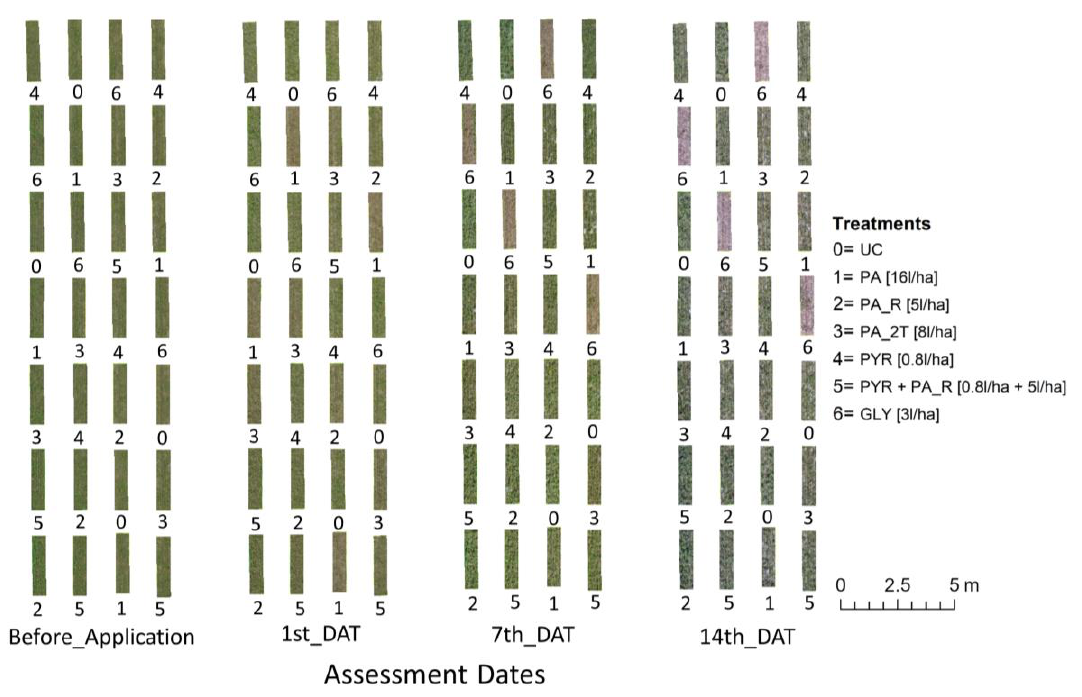
Figure 6. Changes in plant vitality due to different herbicides during the experiment in 2021, expressed by RGB.